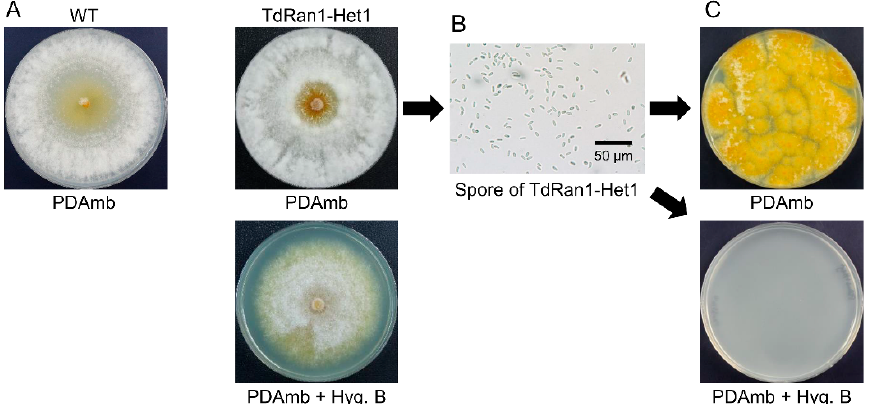
Figure 3. Identification of the CpRan1 -null mutant and segregation of conidia of the CpRan1 -null mutant strain. ( A ) The colony morphology after 10 days of culturing is shown. A further extension of the incubation period did not lead to sporulation on PDAmb with hygromycin B. No mycelial growth of conidia was observed on selective PDAmb media even when the incubation period was extended. ( B ) Conidia harvested from the putative CpRan1 -null mutant strain grown on PDAmb for more than 14 days are shown. ( C ) 100 conidia were spread on PDAmb plates with or without hygromycin B. Strain identifications are provided above the picture. WT and TdRan1-Het1 denote the EP155/2 and heterokaryotic CpRan1 -null mutant strains, respectively.